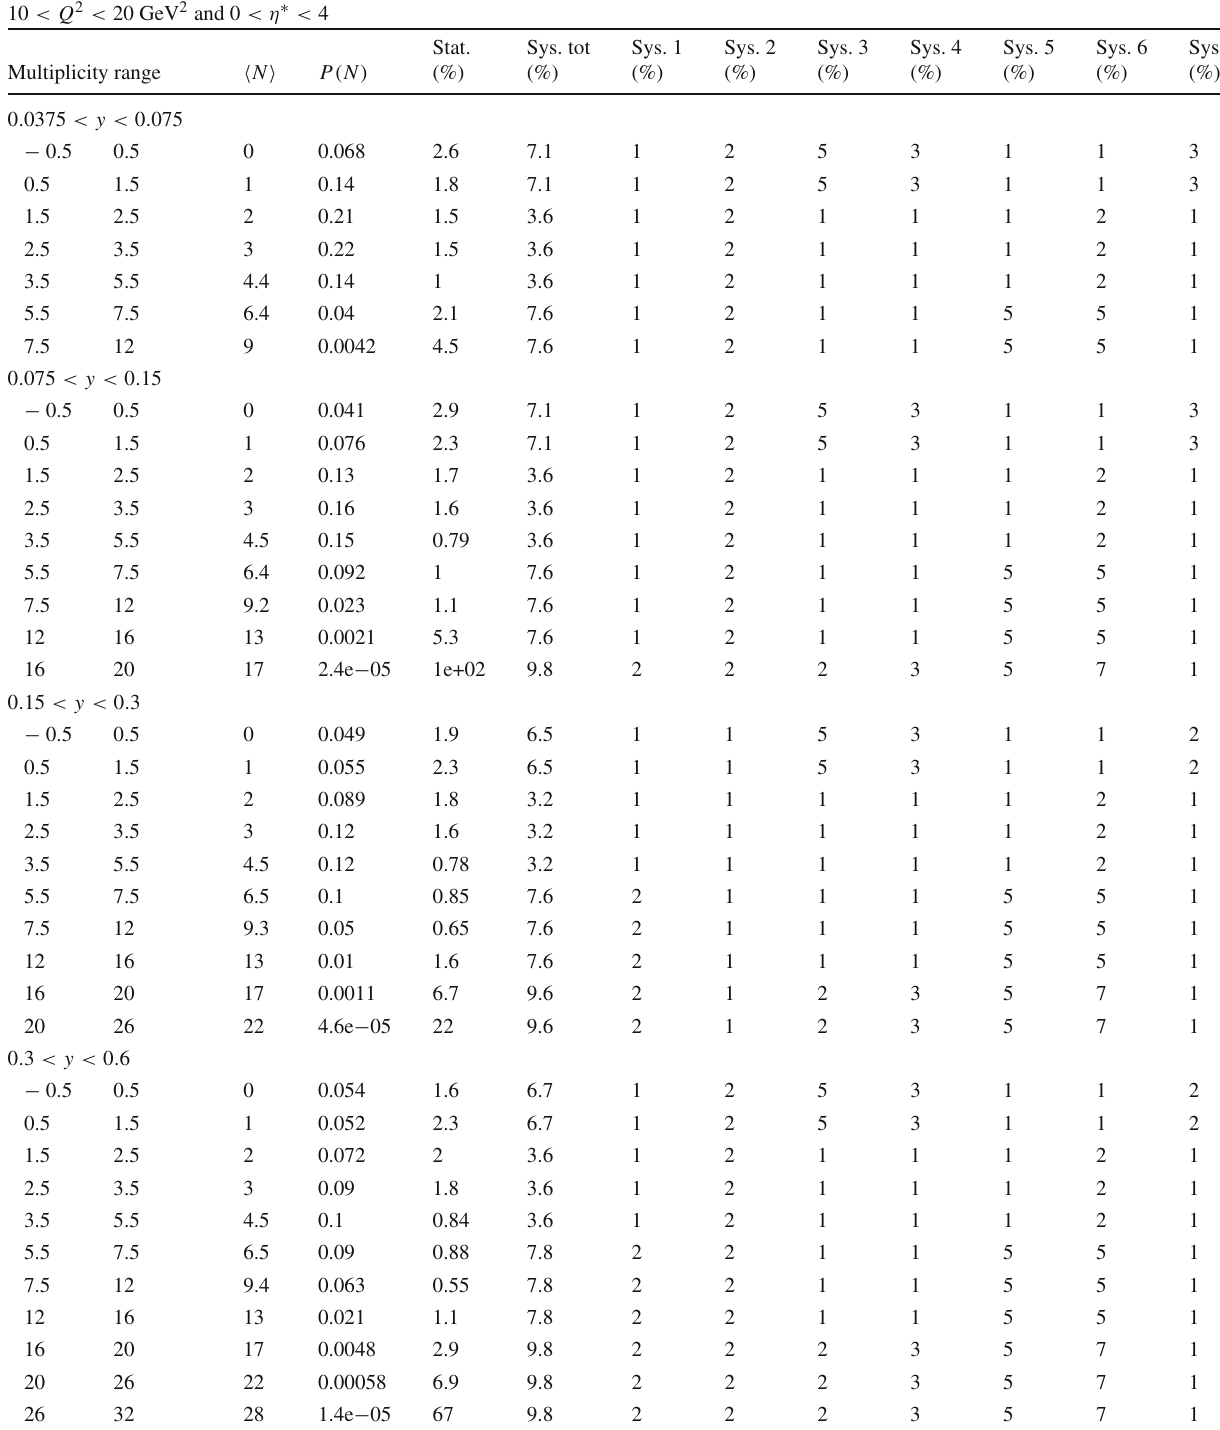
Table 26 Charged particle multiplicity distributions P ( N ) measured √ s = 319GeV with in the ranges of photon virtual- in ep DIS at ity 10 < Q 2 < 20 GeV 2 and charged particle pseudorapidity range Multiplicity distributions in